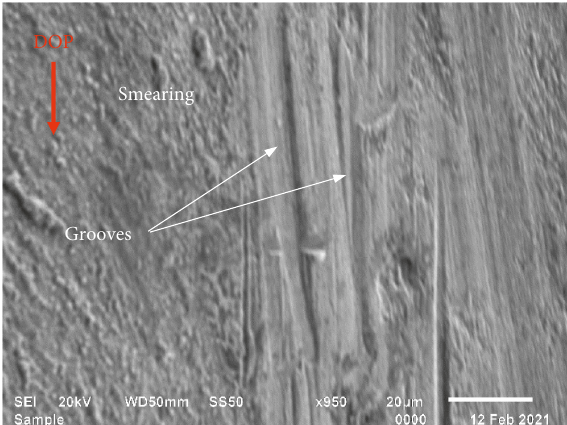
Figure 14: SEM SEI micrograph at the middle point of the penetration hole through a 10mm thick plate.